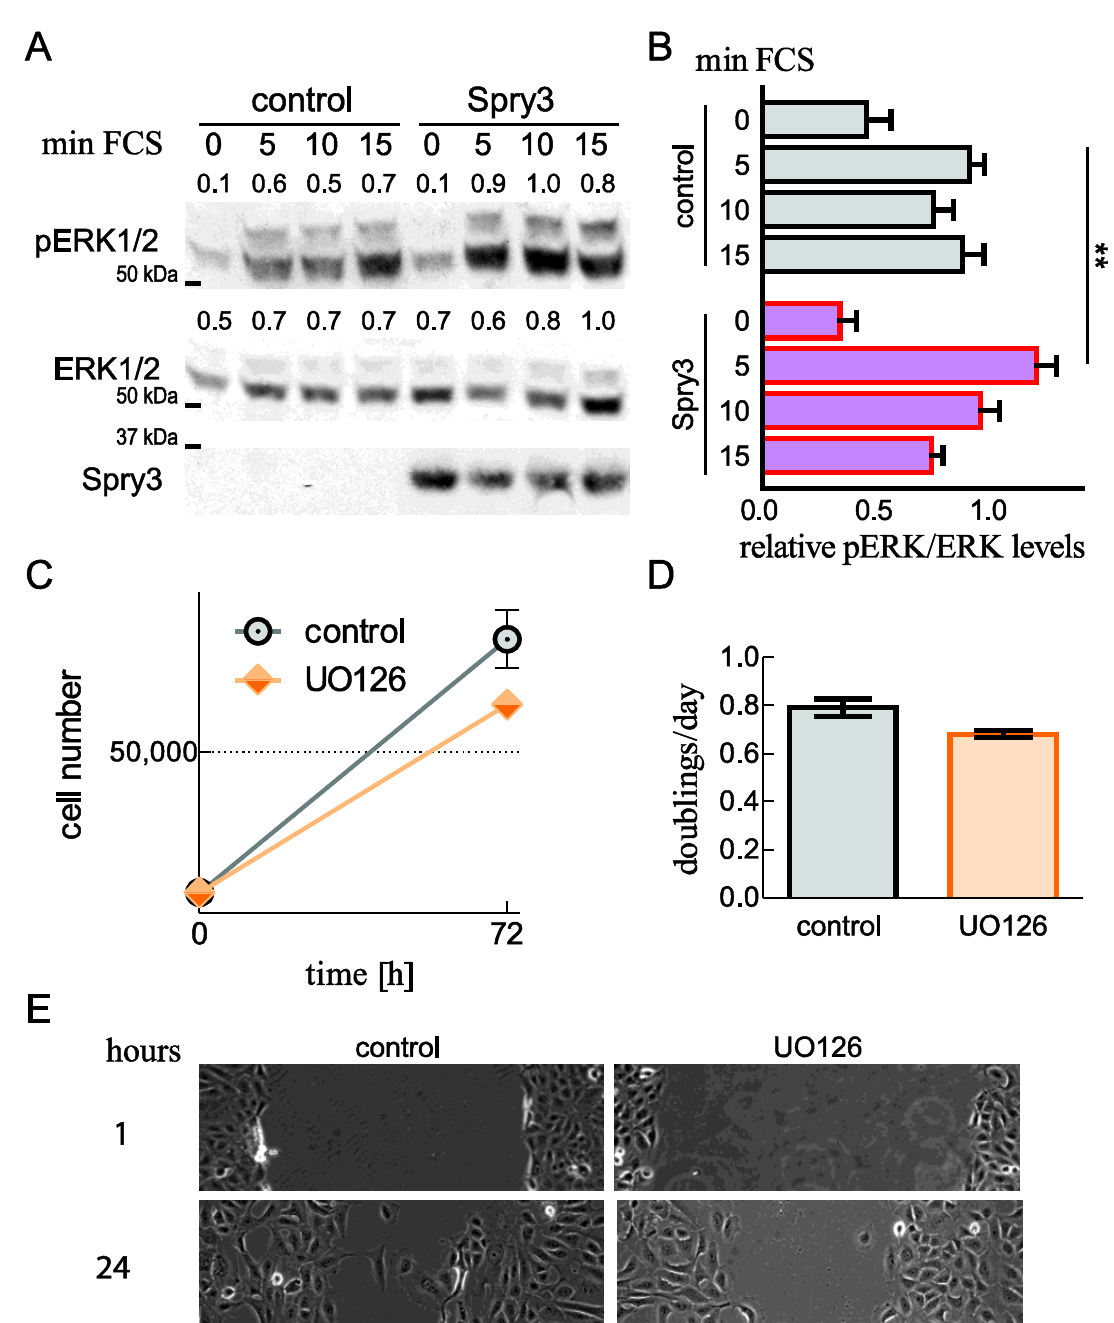
Figure 6. Influence of Spry3 protein on ERK activation. U2OS cells were serum-starved for 24 h and then infected with adenoviruses encoding either a control protein (luciferase) or Spry3 protein. After two more days, cells were incubated with serum for the indicated times. ( A ) Immunoblots were consecutively probed with antibodies recognizing total ERK1/2, pERK1/2 and Spry3. A representative experiment is pictured. Using ImageQuant 5.0, the intensity of the pERK1/2 and ERK1/2 bands were quantified and indicated. The highest values were arbitrarily set as 1. ( B ) The obtained values of pERK were normalized to the corresponding values calculated for the ERK expressions. A summary of calculated mean values ± SEM of the pERK/ERK ratios from three experiments is depicted. Significance between the three groups was calculated by using a one-way ANOVA test in GraphPad Prism. ** p < 0.01; ( C ) After plating, U2OS cells were counted, treated with DMSO (control) or the indicated inhibitor, and counted 72 h later. The numbers are depicted as a growth curve. ( D ) Doublings per day of replicates were calculated. ( E ) Microscopic pictures with 10 × magnification showing gap closure of control as well as MEK inhibitor treated U2OS cells within a period of 24 h are